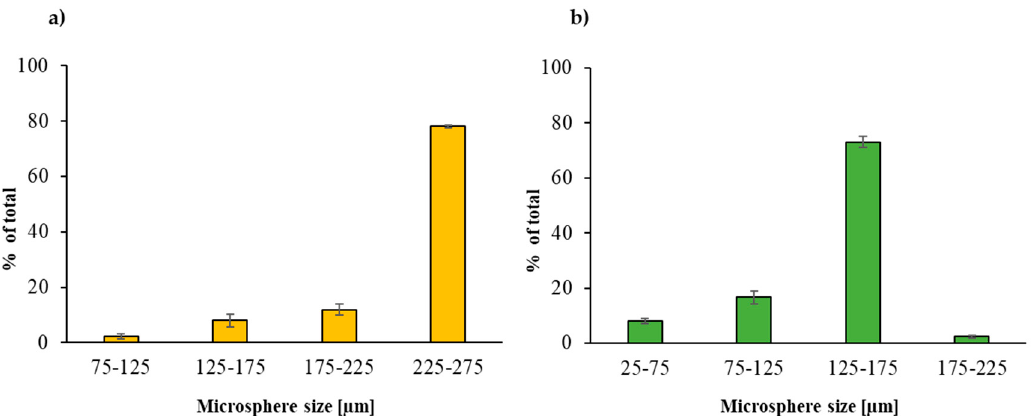
Figure 2. Diameters distribution of the microspheres loaded with herbicides ( a ) for TERPOLYMER and ( b ) for TER/dextrin and TER/maltodextrin.